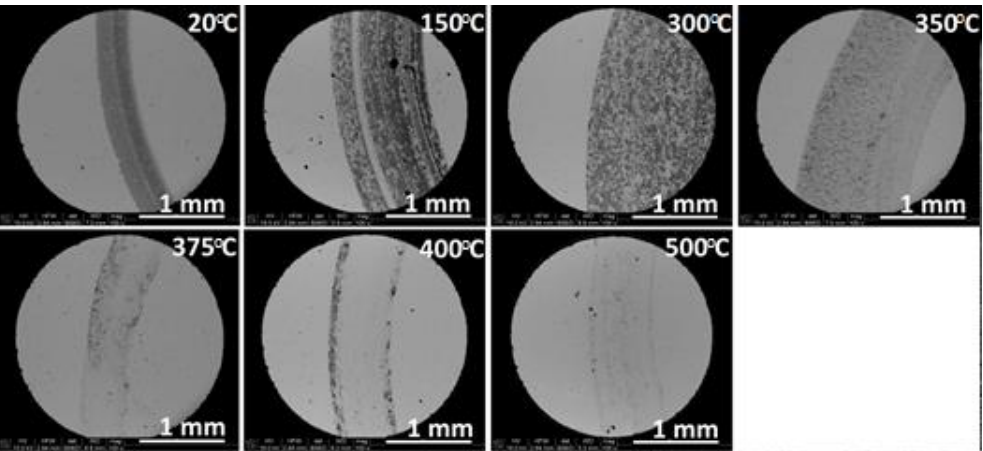
Figure 10. SEM images of the worn surfaces of the ATZ samples after the tribological test performed at temperatures indicated in top right corners of the figures. All magnification were the same. The marker bar indicates a 1 mm distance.